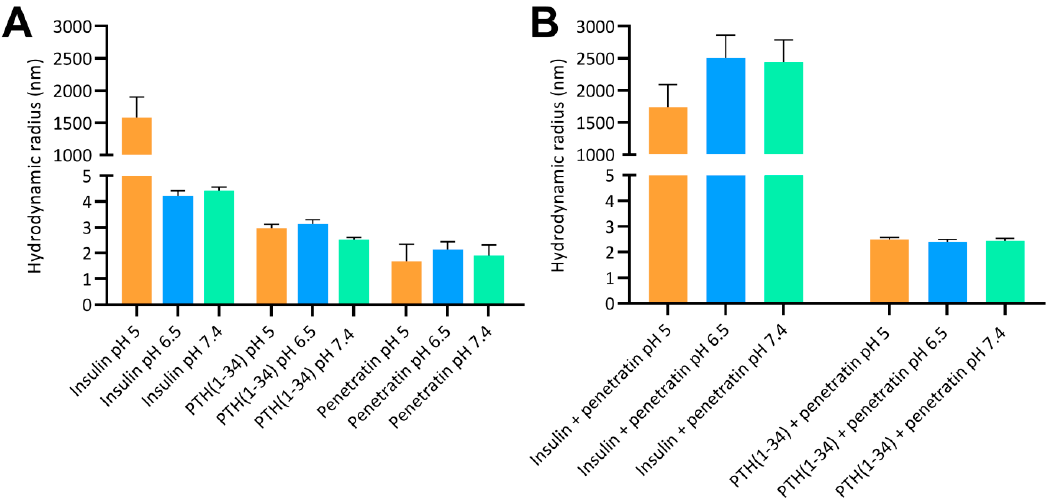
Figure 1. Hydrodynamic radii according to volume distributions at pH 5, 6.5, and 7.4 determined by dynamic light scattering. ( A ): 180 μ M insulin, 180 μ M PTH(1 ‐ 34), or 720 μ M penetratin. ( B ): 180 μ M insulin or 180 μ M PTH(1 ‐ 34) in physical mixture with 720 μ M penetratin. Data are presented as volume mean sizes (N = 3, mean ± SD).